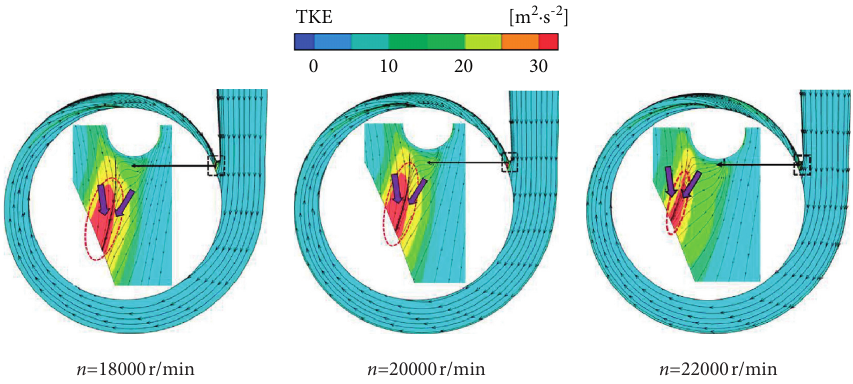
Figure 12: Distribution of the TKE at the middle section of volute.